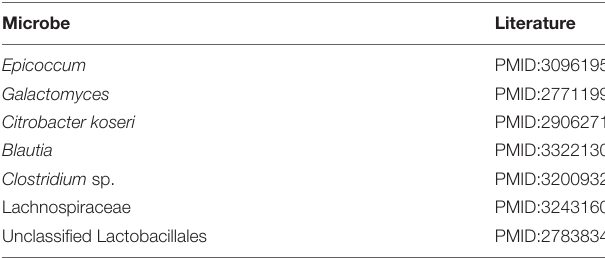
TABLE 2 | Literature verification of the predicted asthma–related microbes.